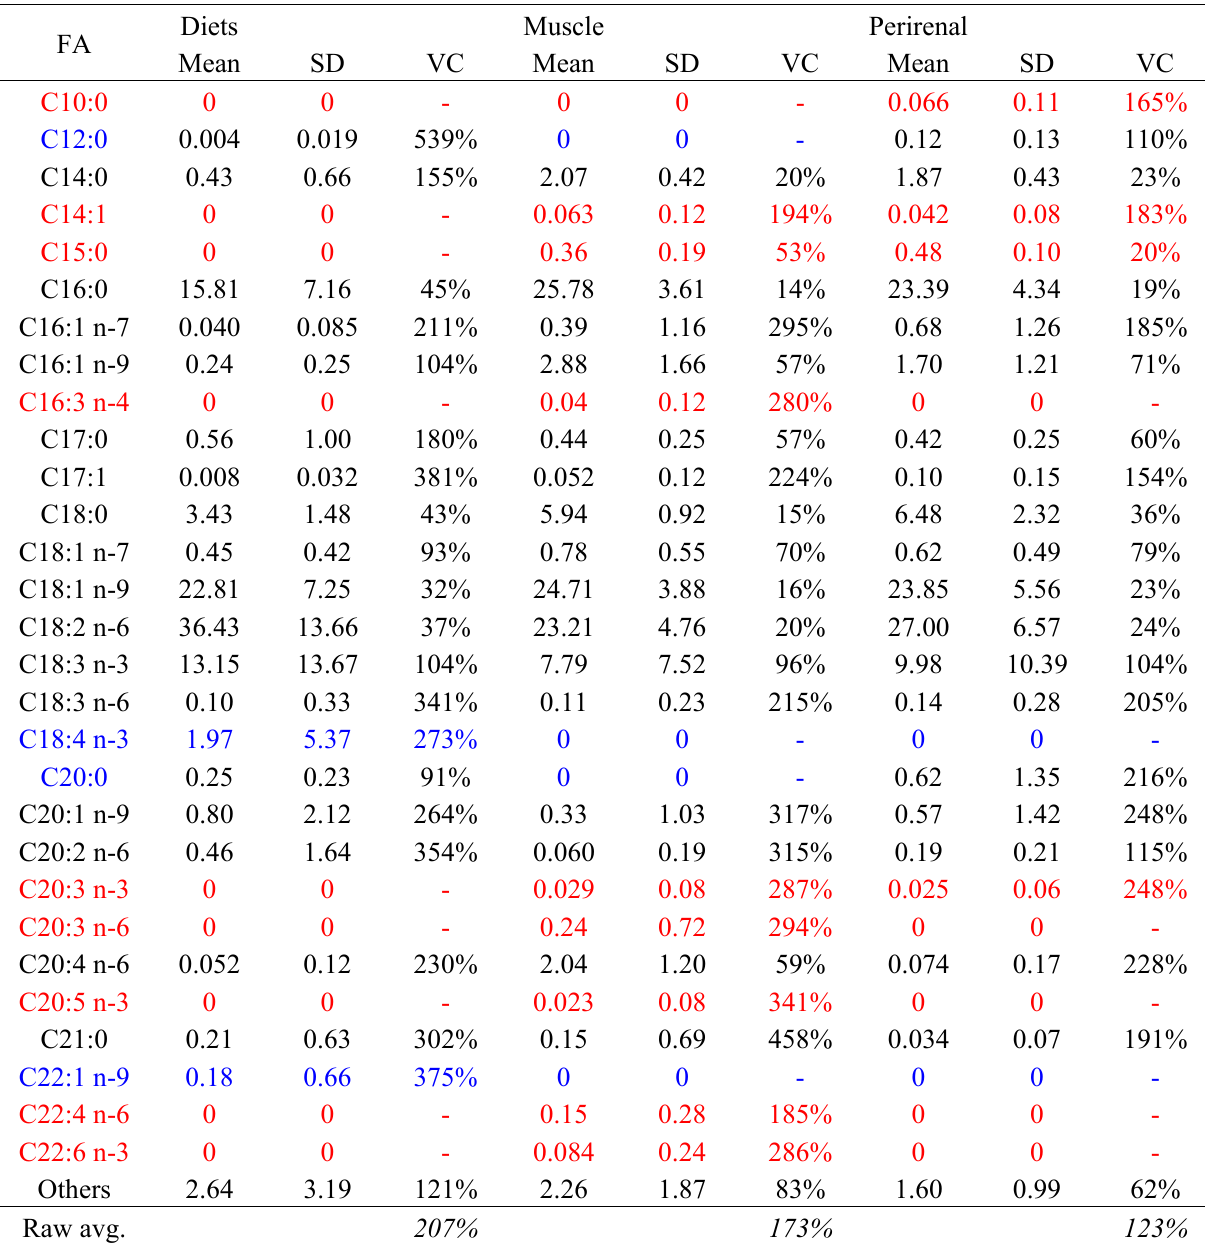
Table 2. Statistics of the recovered or unrecovered FAs, over the whole range detected in the diets (n = 27), in the longissimus dorsi muscle (n = 246) and in the perirenal fat (n =